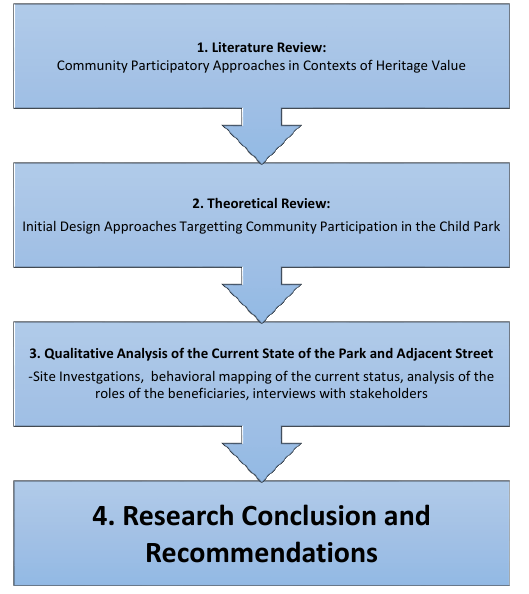
Figure 1 : Research